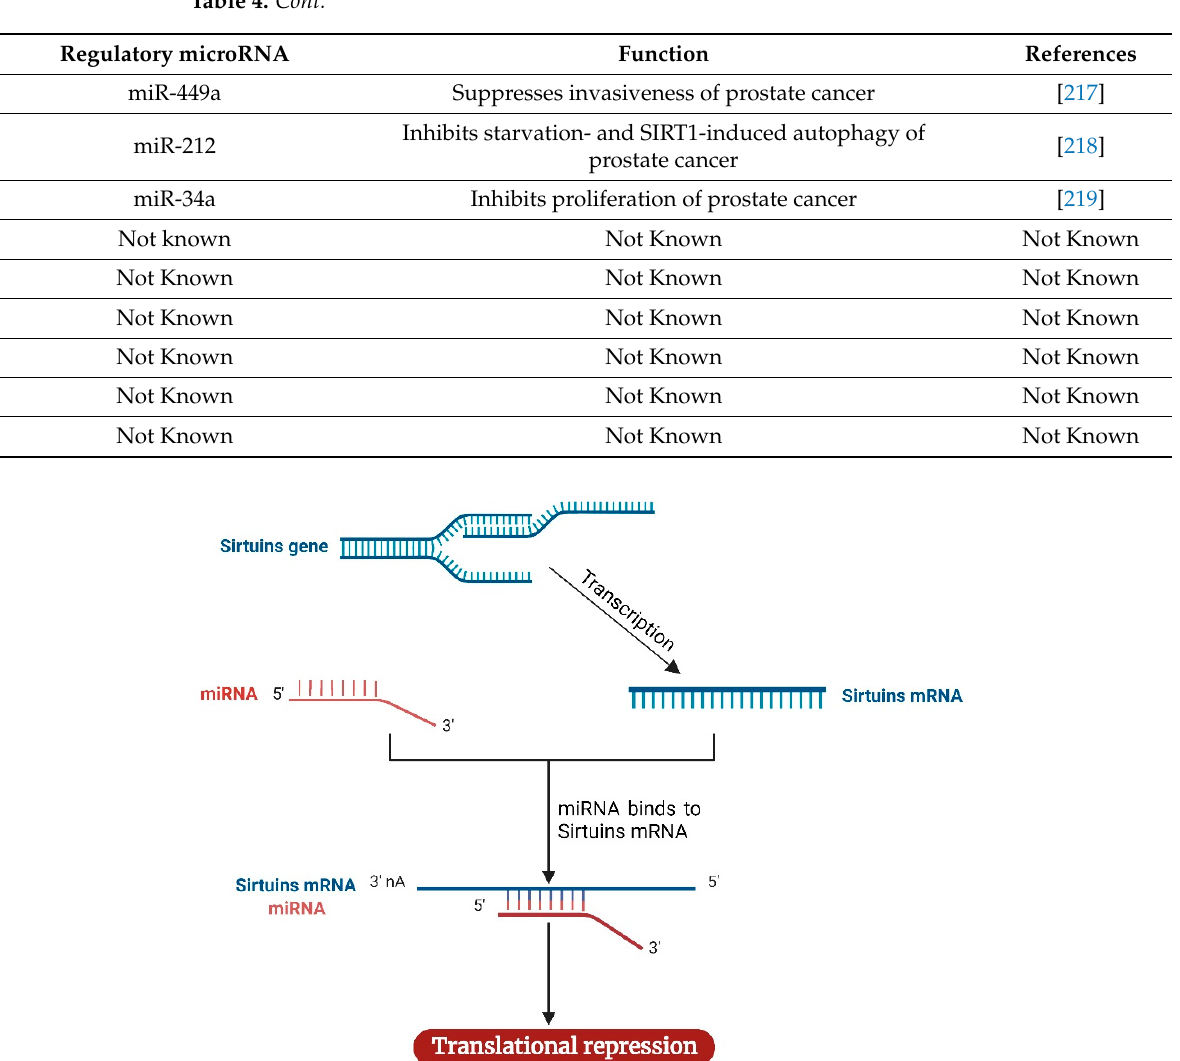
Table 4. Mechanistic Roles of Sirtuins (SIRT1–7) Regulation by miRNAs in Prostate Cancer.